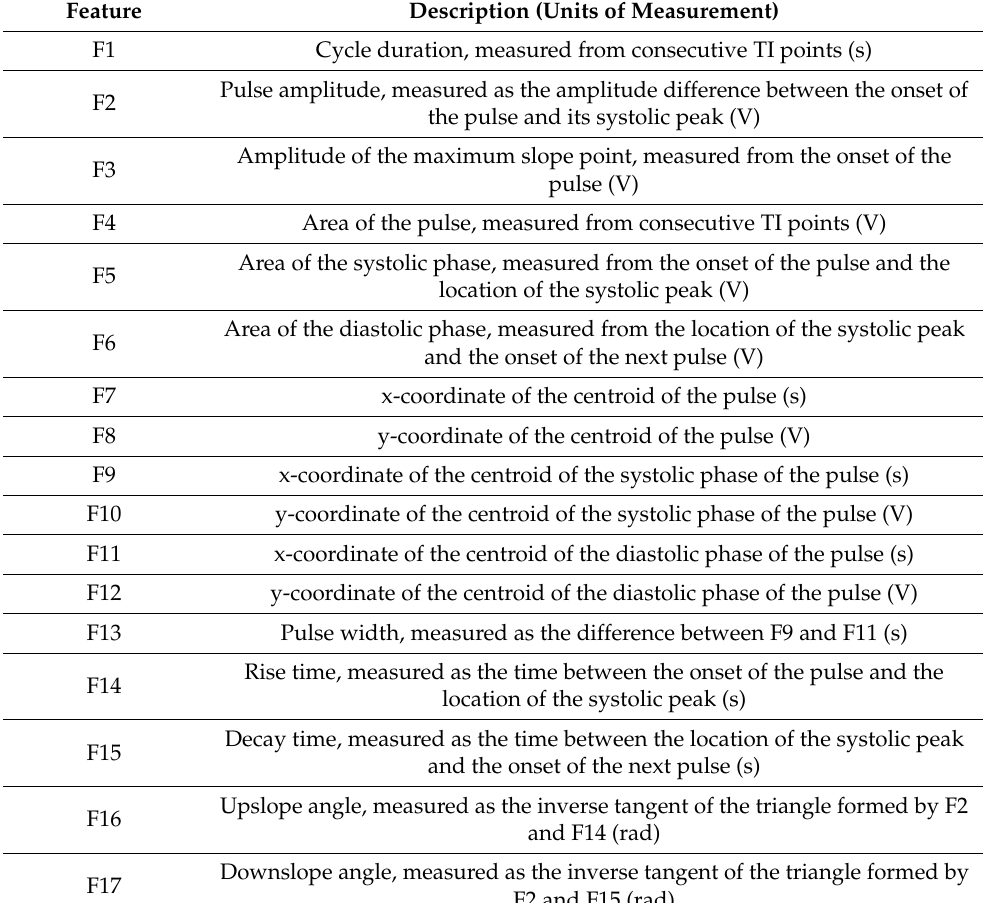
Figure 3. Features extracted from cardiac cycles of the photoplethysmograms, as described in Table 3. ( a ) Features extracted from the cardiac cycle. ( b ) Features extracted from the systolic phase of the cycle. ( c ) Features extracted from the diastolic phase. Blue circles: Onsets segmenting the pulse. Orange circles: Maximum slope point. Red circles: Systolic peak. Yellow circles: Centroid of each area of interest. Table 3. Description of features extracted from the cardiac cycles detected from the photoplethysmo-